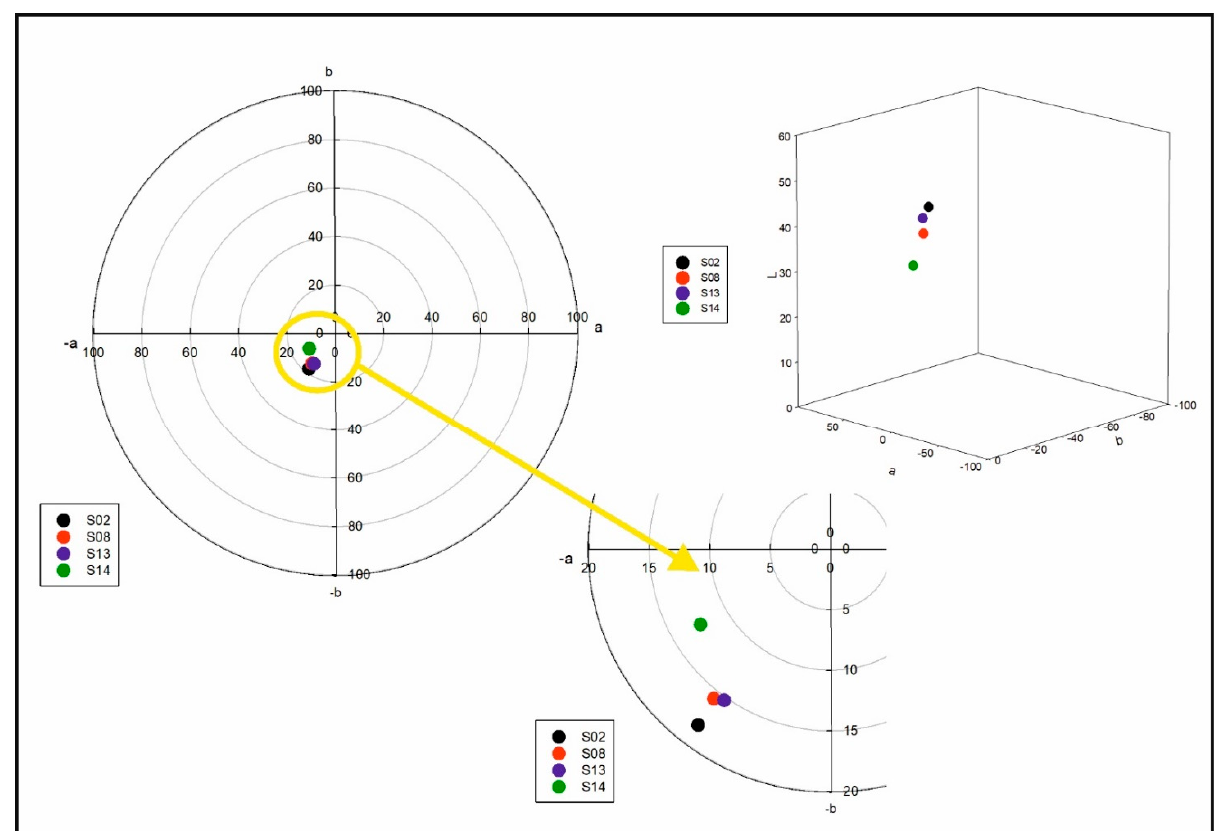
Figure 6. L*a*b* color analysis results of the samples S02, S08, S13, S14. Table 5. Refractive index of the investigated